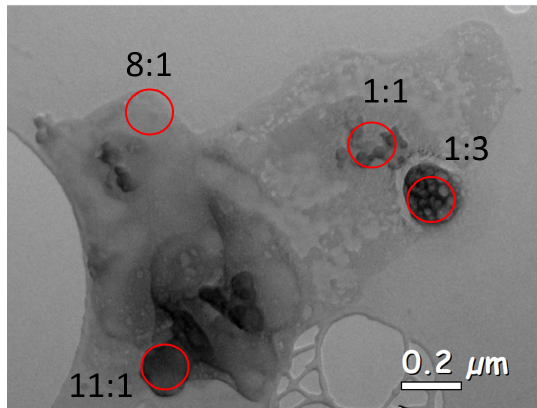
Figure 8. Aqueous K-salt particle with varying levels of Na throughout the particle, with the Na : K weight ratio designated in